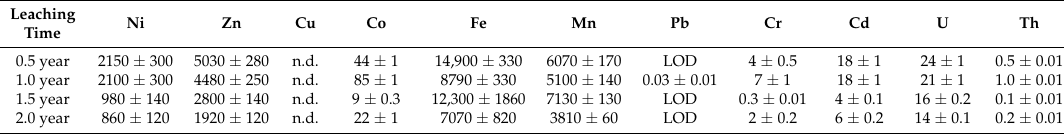
Table 5. Trace element concentrations (ppm) in pregnant leach solutions (PLS) at the Talvivaara mine, Finland. Leaching time is an approximate. Concentrations are mean values of four samples and the uncertainty is their standard